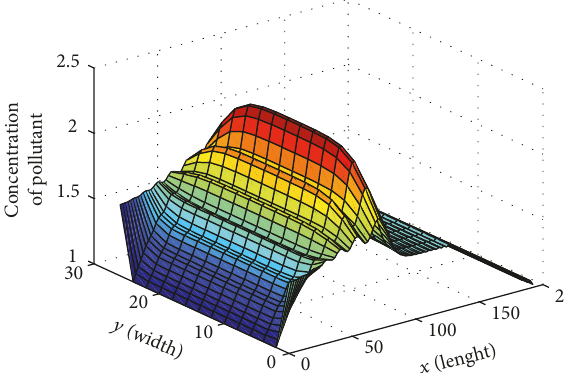
Figure 20: Surface plot of concentration of air pollutant levels for 𝑅